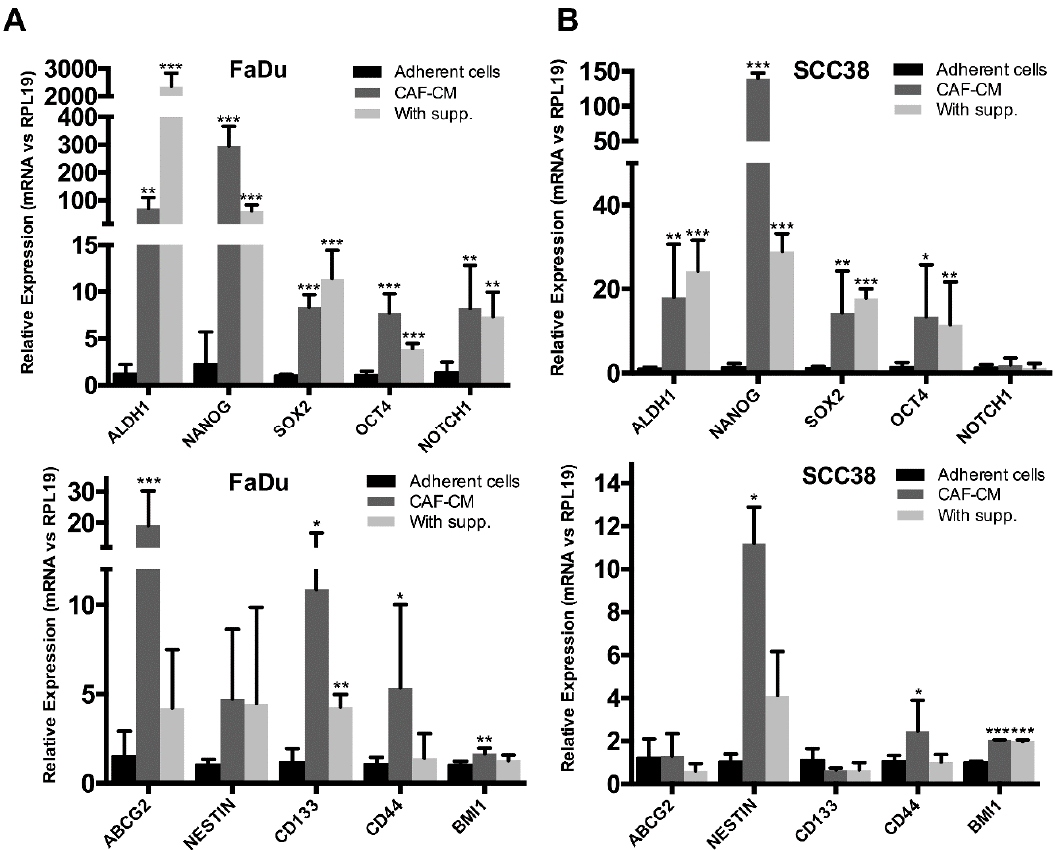
Figure 3. Effect of fibroblast-CM on the expression of stem-related genes in HNSCC cells. Bar chart showing the expression analysis of CSC-related genes by qRT-PCR analysis in FaDu ( A ) and SCC38 ( B ) orospheres formed in CAF-CM and supplemented medium. Adherent monolayer cultures of FaDu or SCC38 cells were used as control. Data were normalized to RPL19 levels and relative to control cells. All data were expressed as the mean ± SD of at least three independent experiments performed in triplicate. * p < 0.05, ** p < 0.01 and *** p < 0.001 by Student’s t -test.